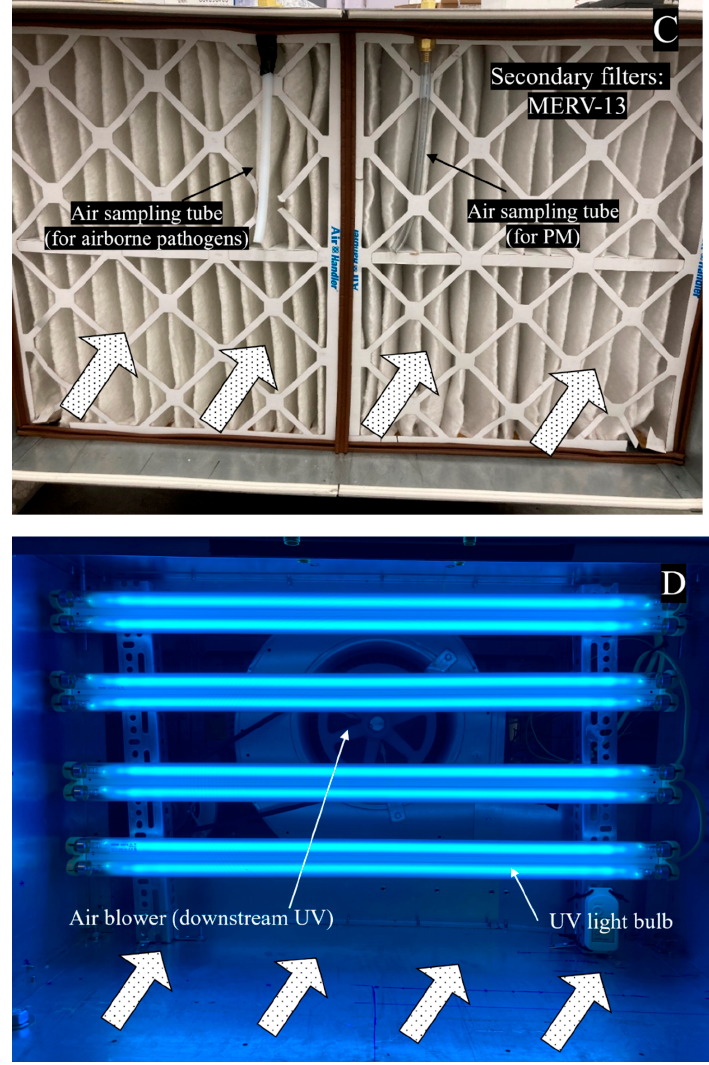
Figure 2. ( A ): Front view of the upgraded FastAir prototype with UV-C lamps enclosed and a controller box attached above the air outlet. ( B ): Side view of the upgraded FastAir prototype. MERV-8 filters can be seen at the air inlet. ( C ): After MERV-8 filters were removed, MERV-13 filters can be seen as the second filtration layer. Aluminum mesh filters follow MERV-13 filters to protect MERV filters from degradation caused by long-term UV irradiation. ( D ): Eight UV-C light bulbs were in- stalled on each side of the FastAir prototype. Each light fixture supported twin UV-C light bulbs. The air blower can be seen downstream from the UV-C lamp. The gradient of the air flow arrows signifies progressively cleaner air (from ( B – D )).